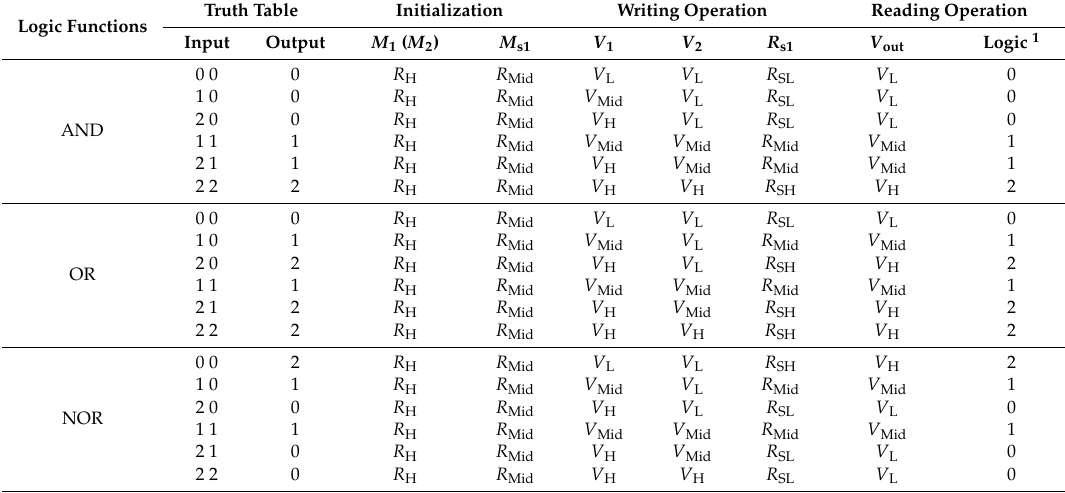
Table 3. The overall information of the other ternary gates: AND, OR, and NOR gates.